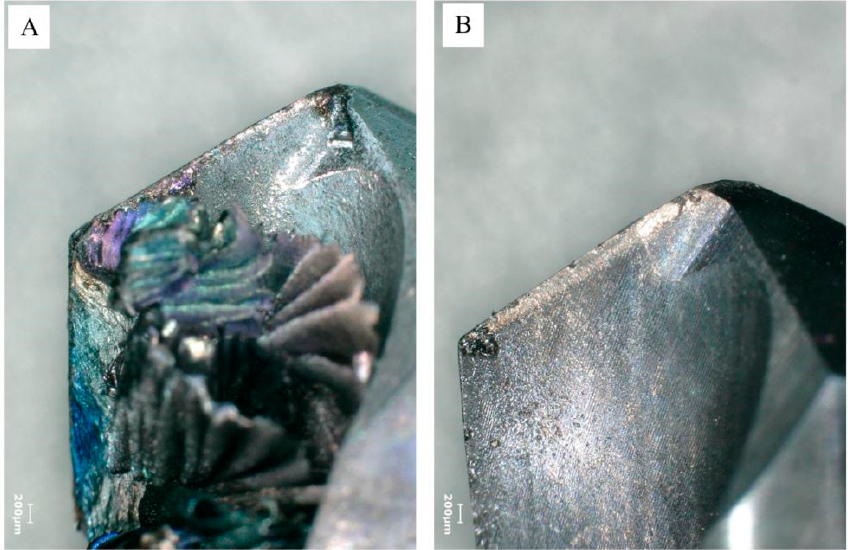
Figure 10. The effect of VAD on the tool-chip welding process at N = 37.68 m/min and f = 0.075 mm/rev for ( A ) conventional and ( B ) A m = 0.25mm.